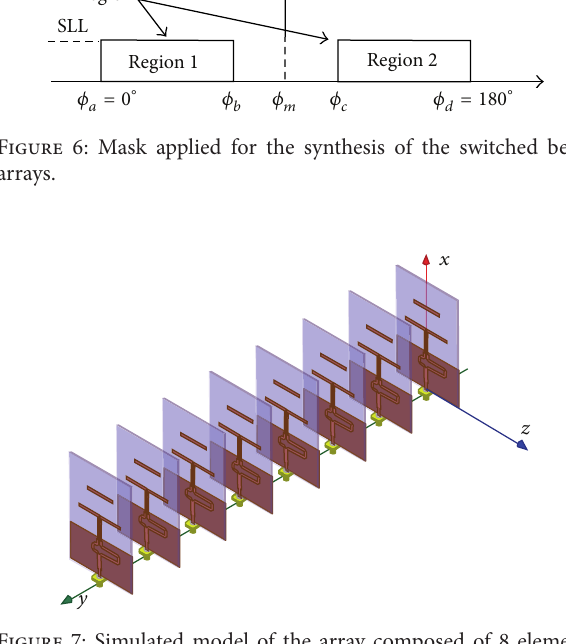
Figure 7: Simulated model of the array composed of 8 elements placed along the 𝑦